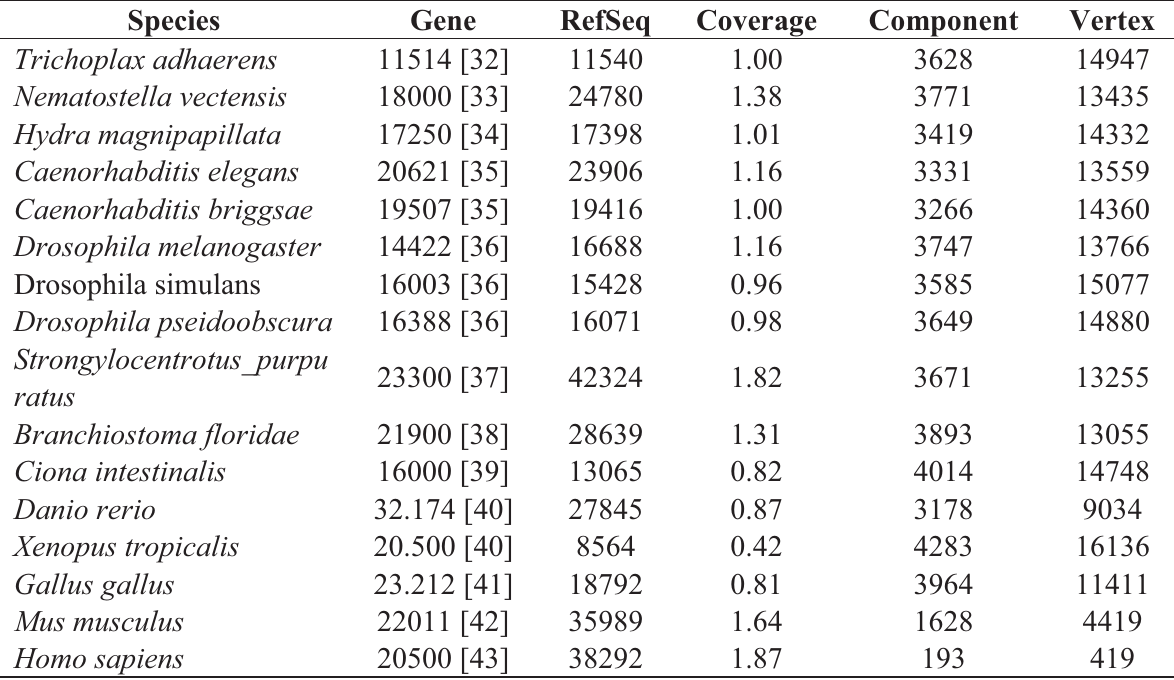
Table S1. Parameters of RefSeq datasets of various species and sequence similarity networks of Human Swiss-Prot/Refseq comparisons.